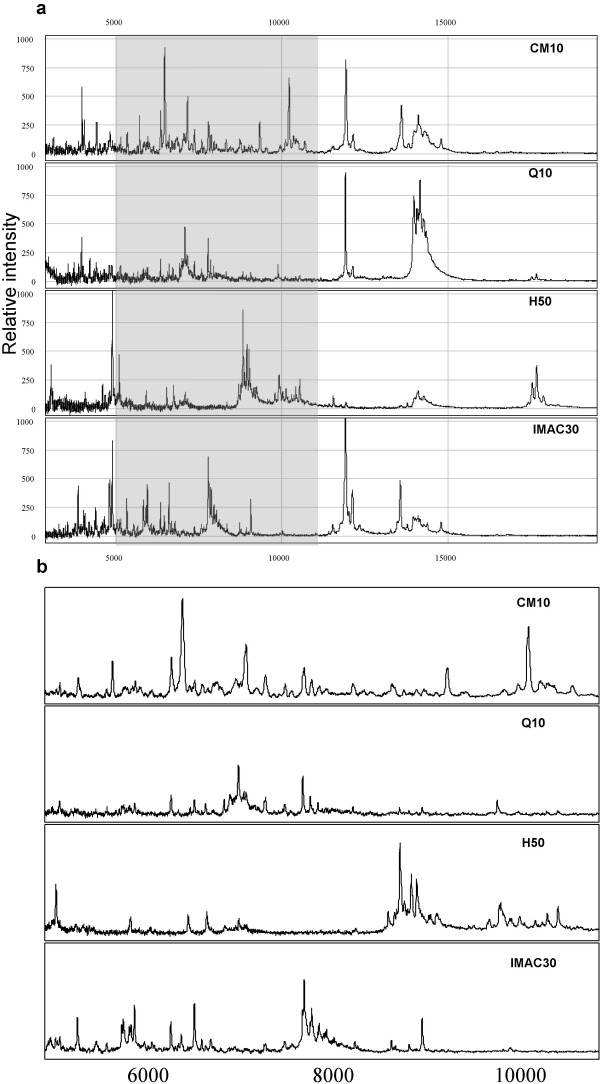
Representative SELDI-TOF MS spectra of CSF in denaturing buffer on CM10, Q10, H50 and IMAC30 arrays. a) CSF was diluted 1:1 in denaturing buffer 9.5 M urea, 2% CHAPS, 50 mM Tris-HCl, pH 9.0. Denatured CSF samples were diluted 1:4 in appropriate binding buffer and processed on: CM10 with 100 mM ammonium acetate pH 4.0; Q10 with 100 mM Tris-HCl pH 9.0; H50 with 10% AcN, 01% TFA; and IMAC30 with 100 mM Na phosphate, 0.5 M NaCl pH 7.0 and 100 mM Cu sulphate activation. ProteinChip arrays were prepared with SPA. b) Enlargement of the shaded spectra region showing peaks between m/z range of 4–11 kDa.